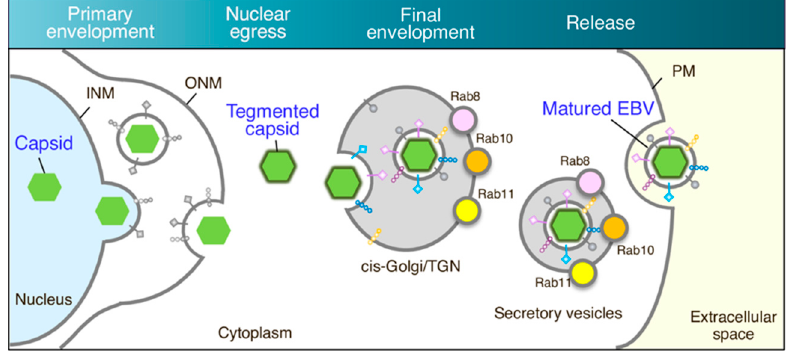
Figure 5. EBV virion maturation model. Replicated viral DNAs are packaged into capsids in the nucleoplasm. Nucleocapsids acquire primary envelopes by budding through the inner nuclear membrane (INM) into the perinuclear space. Perinuclear enveloped virus particles undergo de-envelopment, mediated by the fusion of the primary envelope with the outer nuclear membrane (ONM) (nuclear egress). Tegument-coated nucleocapsids then undergo a final envelopment step by budding into intracellular compartments derived from the cis-Golgi and trans-Golgi networks, producing mature virions. Rab8a, Rab10, and Rab11a-positive vesicles containing mature virions are then transported to the cell surface and fuse with the PM to release EBV virions into the extracellular milieu.